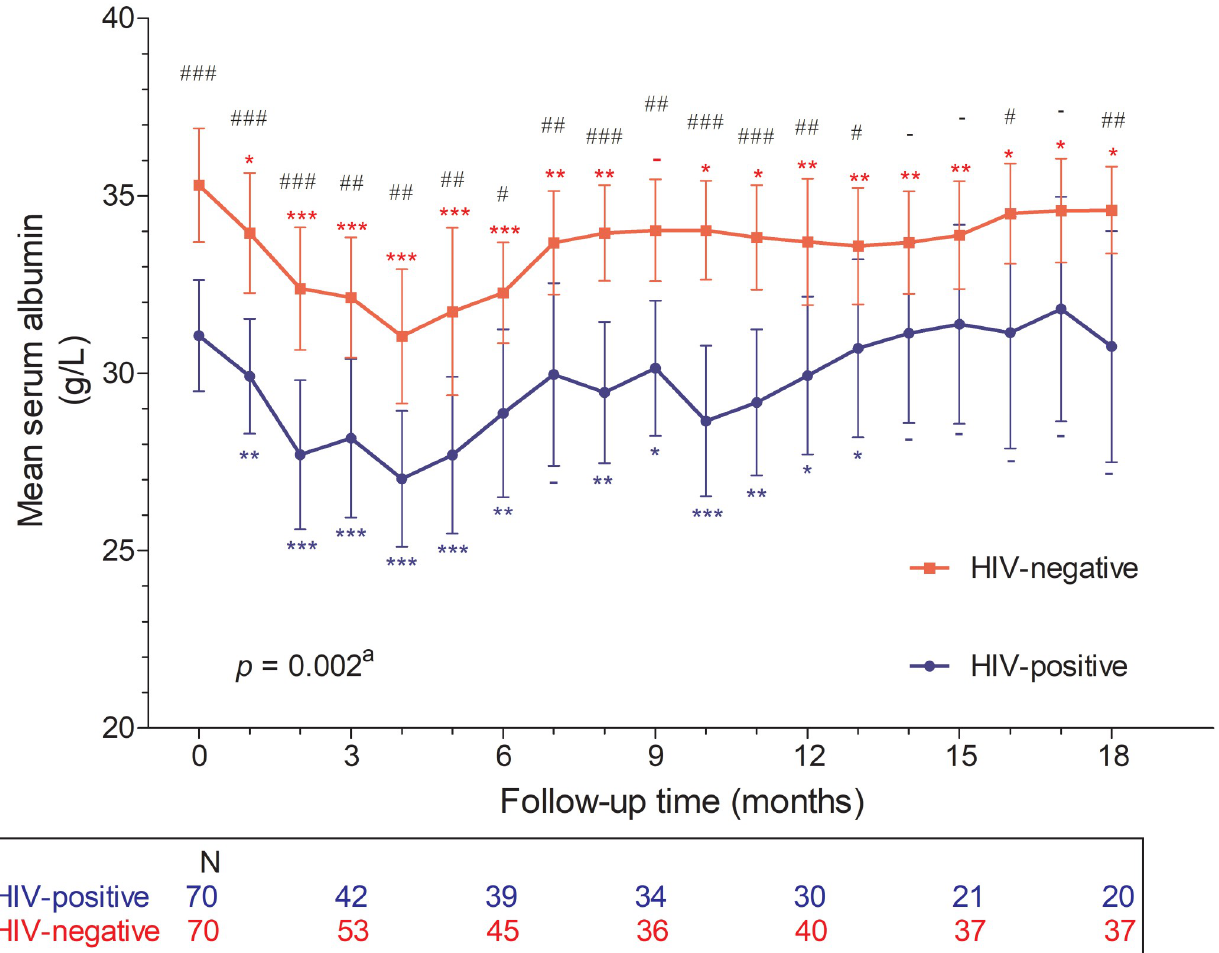
Fig 1. Monthly mean serum albumin with confidence intervals according to HIV-status. HIV, human immunodeficiency virus a Two-factor analysis of variance for repeated measurements comparing monthly mean serum albumin over 18 months according to HIV status # independent t-test comparison of monthly mean serum albumin between the HIV-negative and HIV-positive cohorts p < 0.05 (##, p < 0.01; ###, p < 0.001; -, p > 0.05) � paired t-test comparison of means between baseline and follow-up monthly serum albumin p < 0.05 ( �� , p < 0.01; ��� , p < 0.001; -, p > 0.05) N, number of study patients who presented and were sampled at specified clinic visit.